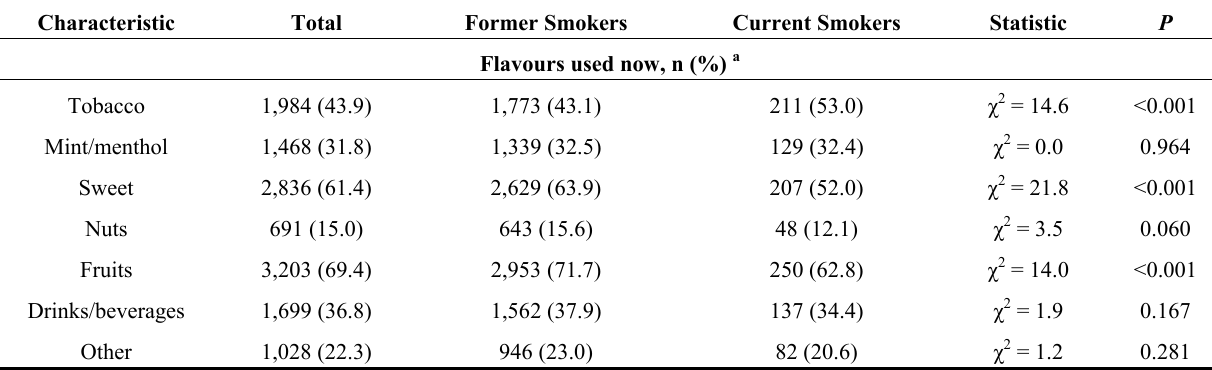
Table 2. Patterns of flavourings use in the study population and